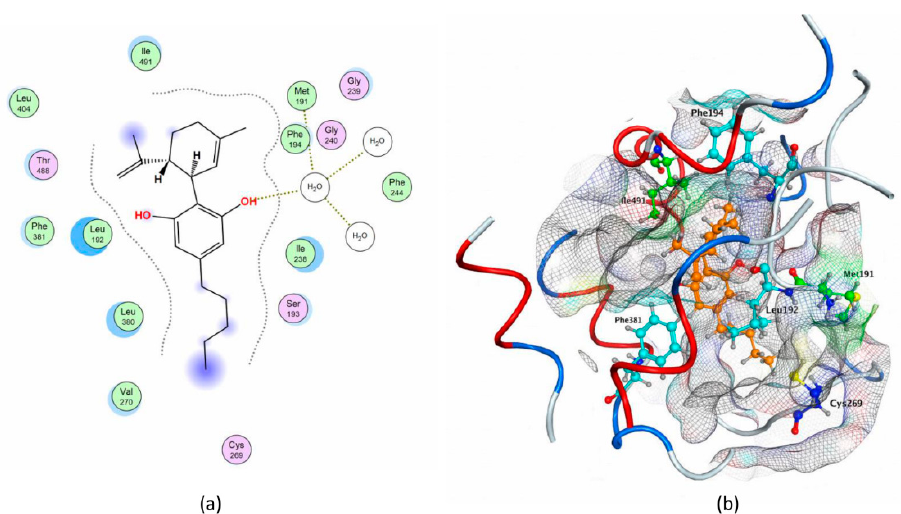
Figure 6. Pattern of CBD interactions with key rFAAH residues. ( a ) In the 2D structure the solvent contact is reported in yellow. ( b ) In the 3D structure the following details are reported as sticks: CBD, in orange; Leu192, Phe194 and Phe381, in cyan; Met191 and Ile491, in green; Cys269, in blue. The pictures were generated by means of the MOE software.